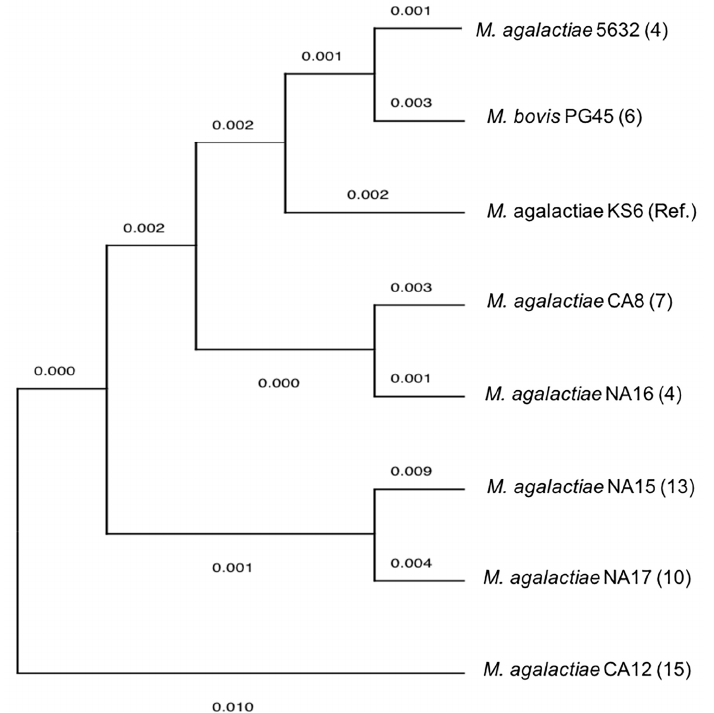
Figure 2. Maximum likelihood Phylogenetic tree of Mycoplasma agalactiae isolated from ticks infesting sheep and goats with 16S rRNA gene sequences (1500 bp) using Mega 11. In brackets, the number of SNPs identified in each sequence is compared with the reference sequence ( M. agalactiae KS6).